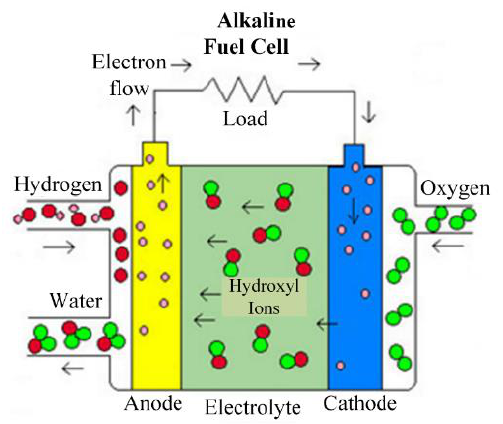
Figure 65. Operation of alkaline fuel cell; the electrolyte used in this system is alkaline fuel-aqueous solution of potassium hydroxide (KOH) solution of potassium hydroxide (KOH) [209].